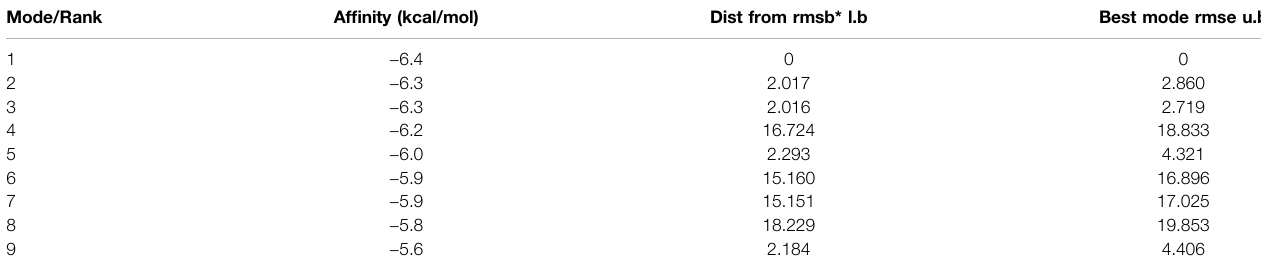
TABLE 3 | MOE scores of hP2X7 protein and gallic acid (kcal/mol). Mode/Rank Af fi nity (kcal/mol) Dist from rmsb*